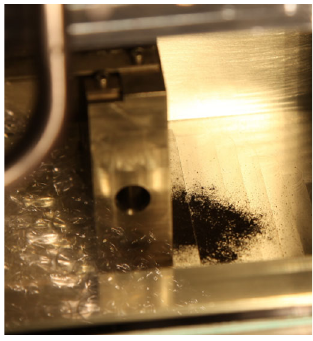
FIG. 13. Photo of the powder spilled out from the end of the trough.